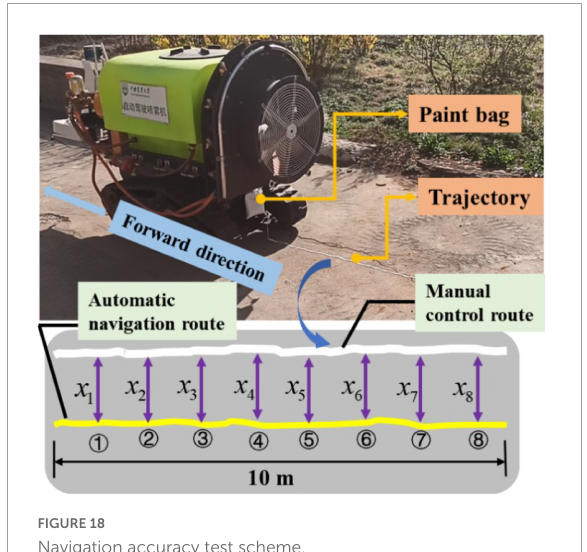
FIGURE18 Navigation accuracy test scheme.